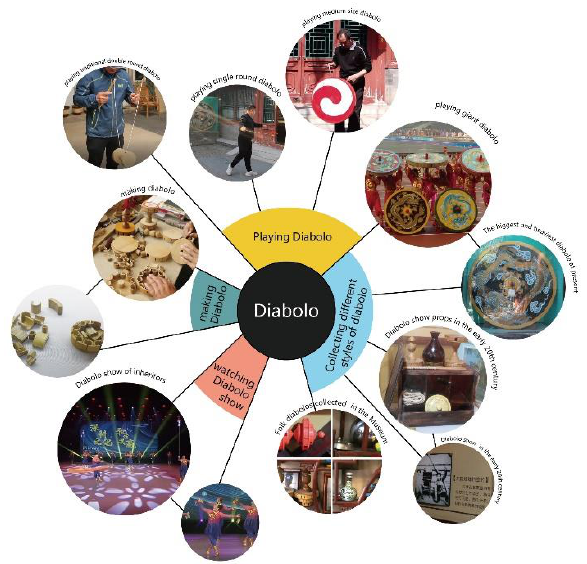
Figure 4 . Prototypes of Diabolo Events. Source: Authors The original ICH events occur at different times and spaces with non-structural relationships between the events. Through the narrative of digital media, the original events can be integrated into virtual spaces and revealed to the audience with specific temporal and logical semantic relationships. The audience understands the meaning by the interaction.